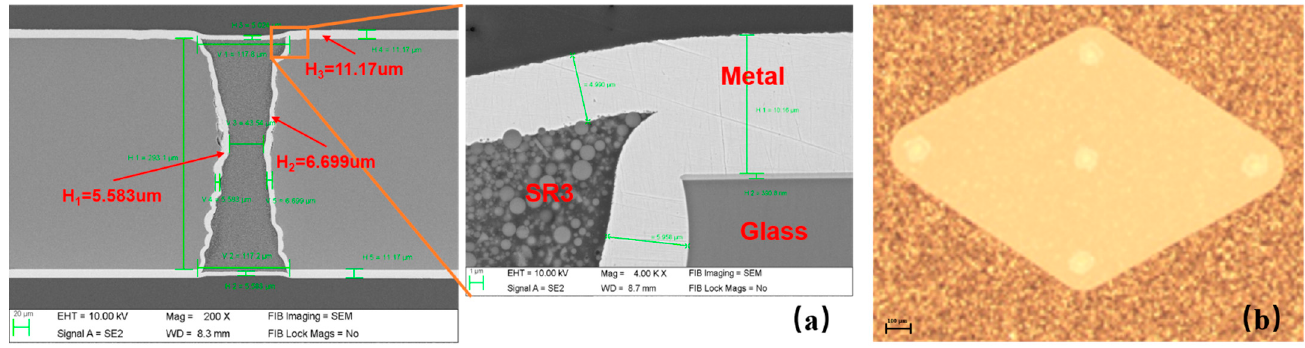
Figure 9. TGV details. ( a ) is a cross-section of the via TGV structure filled with metal and SR3. ( b ) is a group of TGVs for one strip covered by a small pad.